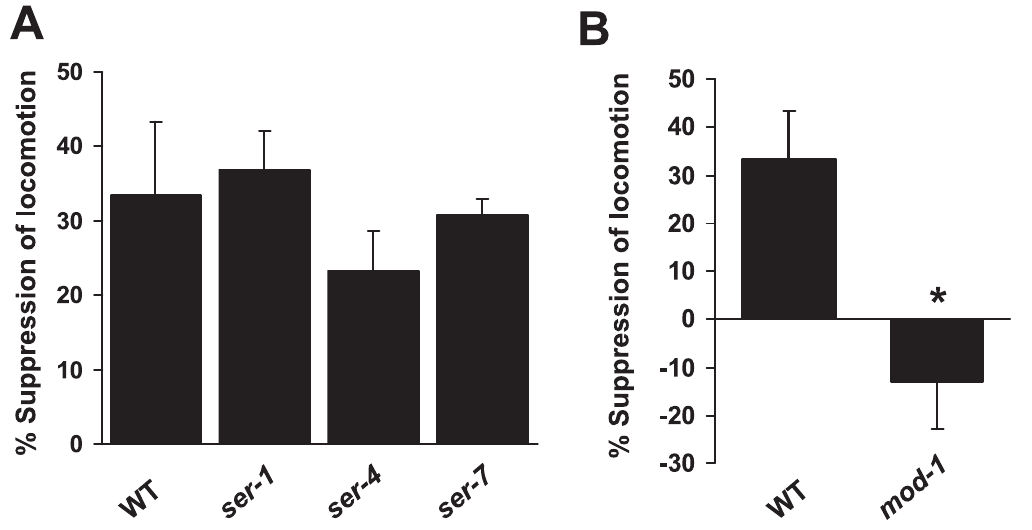
Figure 4. The cocaine-induced hypolocomotor response requires the ionotrpic serotonin receptor MOD-1. (A) The metabotropic serotonin receptor mutants ser-1, ser-4 and ser-7 do not show a severe defect in the cocaine-induced hypolocomotor response. (B) The ionotropic serotonin receptor mutant mod-1 lacks the hypolocomotor response induced by cocaine. *p=0.01 (ANOVA). Error bars: SEM.